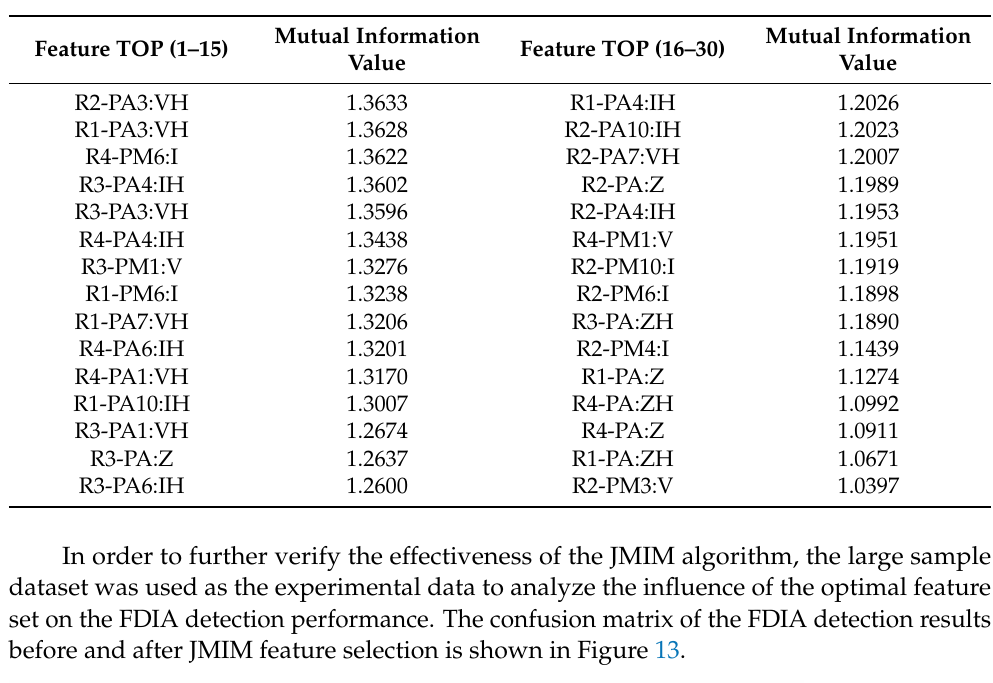
Table 3. Optimal features and mutual information values selected by the JMIM algorithm (TOP 30).